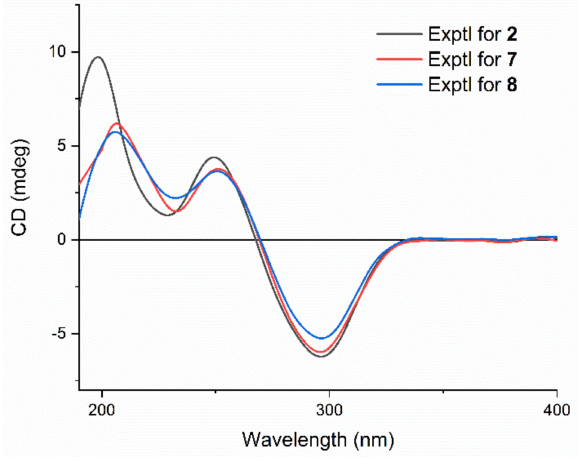
Figure 7. Experimental ECD spectra of compounds 2 , 7 , and 8